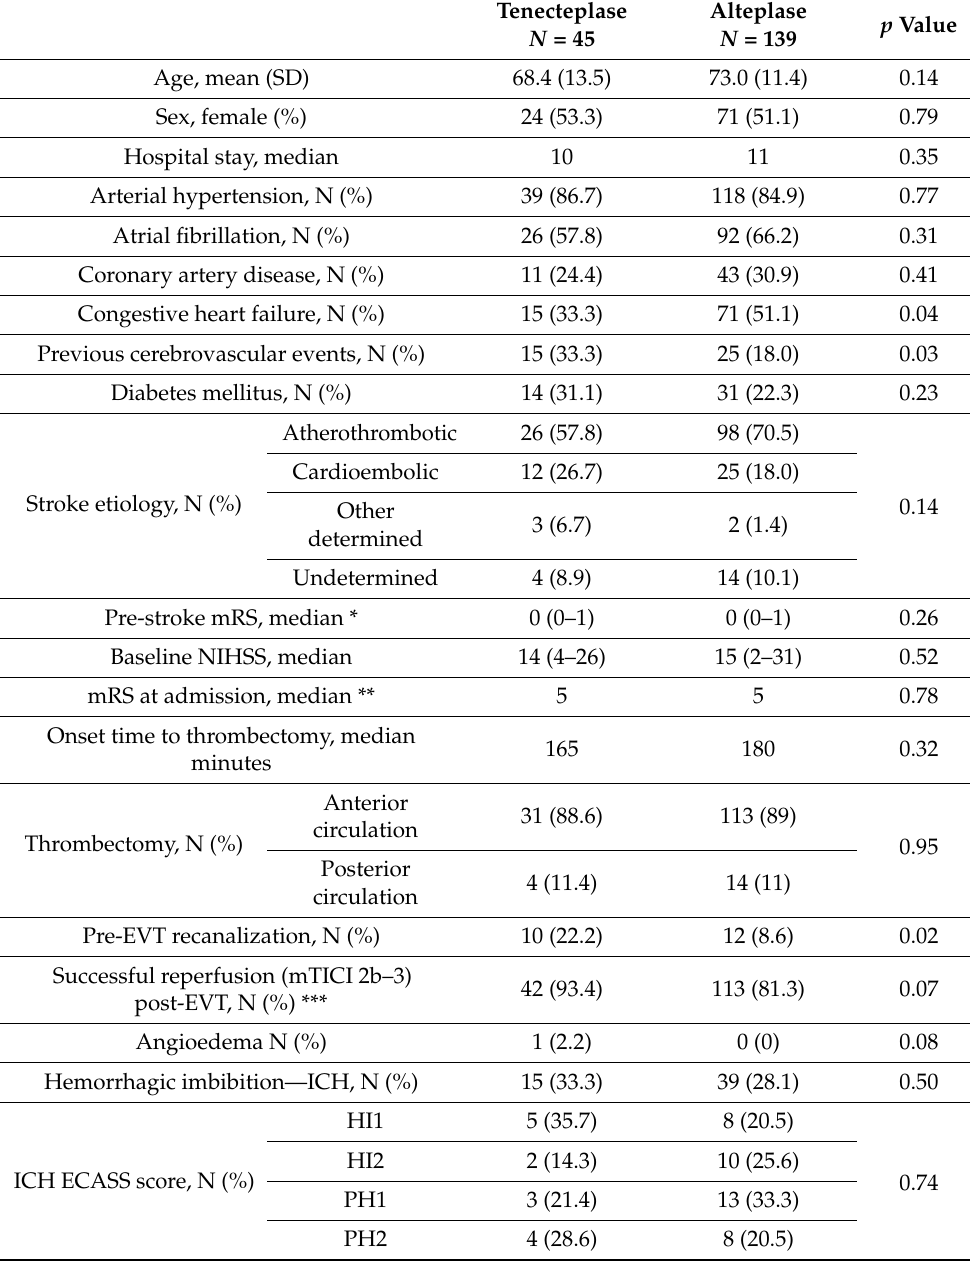
Table 1. Baseline